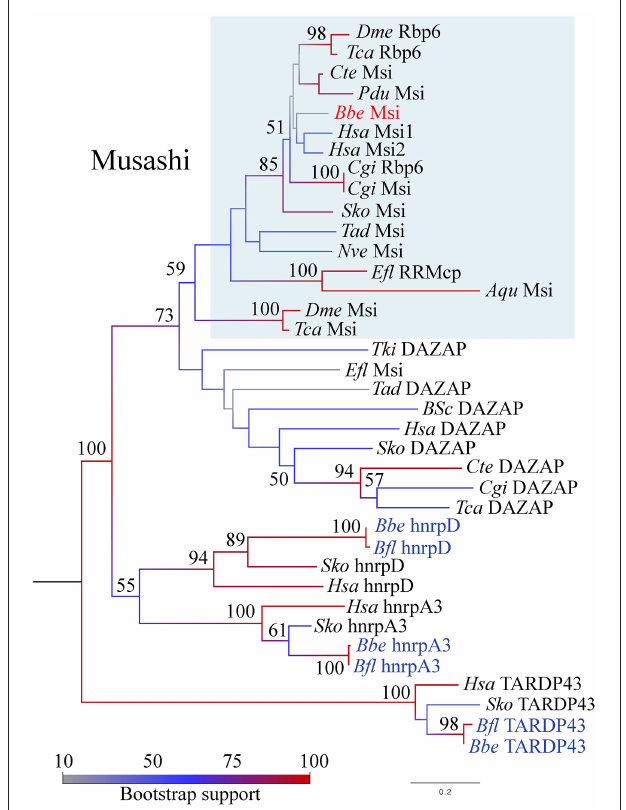
FIGURE 2 | Phylogenetic analysis of the RRM domain containing protein family in animals, including Musashi-like, DAZAP, hnrpD, hnrpA, and TARDP43 clades. Maximum likelihood analysis was performed in MEGA5 with 1000 bootstrap replicates, indicated as a percentage at each node. The model used was rtREV + G with five rate categories on 173 sites. Branches are colored according to the level of node support; amphioxus species names are highlighted in blue and red, with the clade representing musashi genes boxed in blue. Protein names are taken directly from the literature where available. See text for details. Species name abbreviations are as follows: Aqu, Amphimedon queenslandica ; Bfl, Branchiostoma